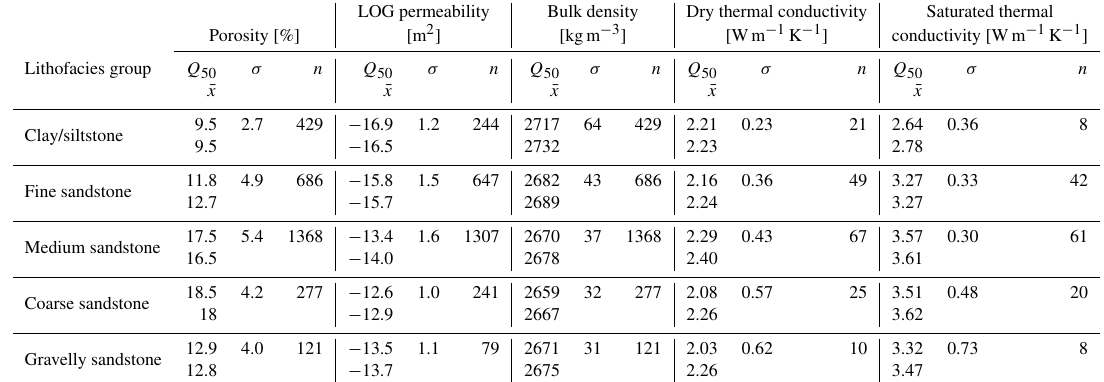
Table 1. Average (median: Q 50 , arithmetic mean: ¯ x) property values, standard deviation ( σ ) and number of samples ( n ) for each lithofacies